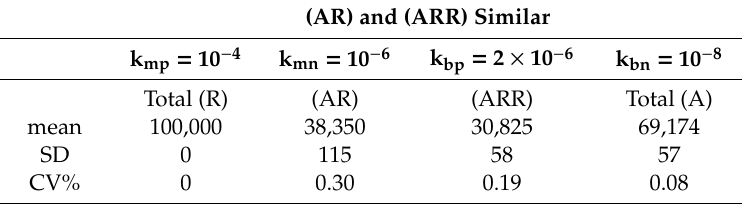
Table 4. Results of 25 calculations with constant initial value of ( R ) and fixed reaction constants.